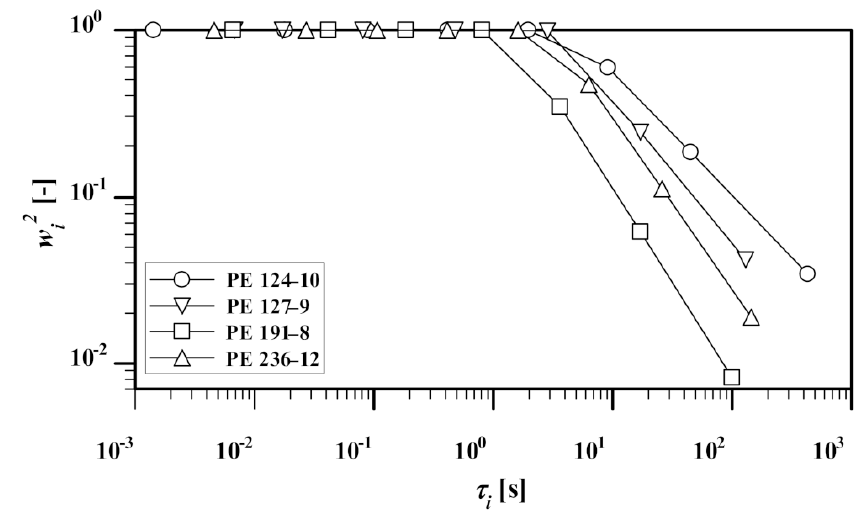
Figure 12. Mass fraction of dynamically diluted chains w 2 relaxation